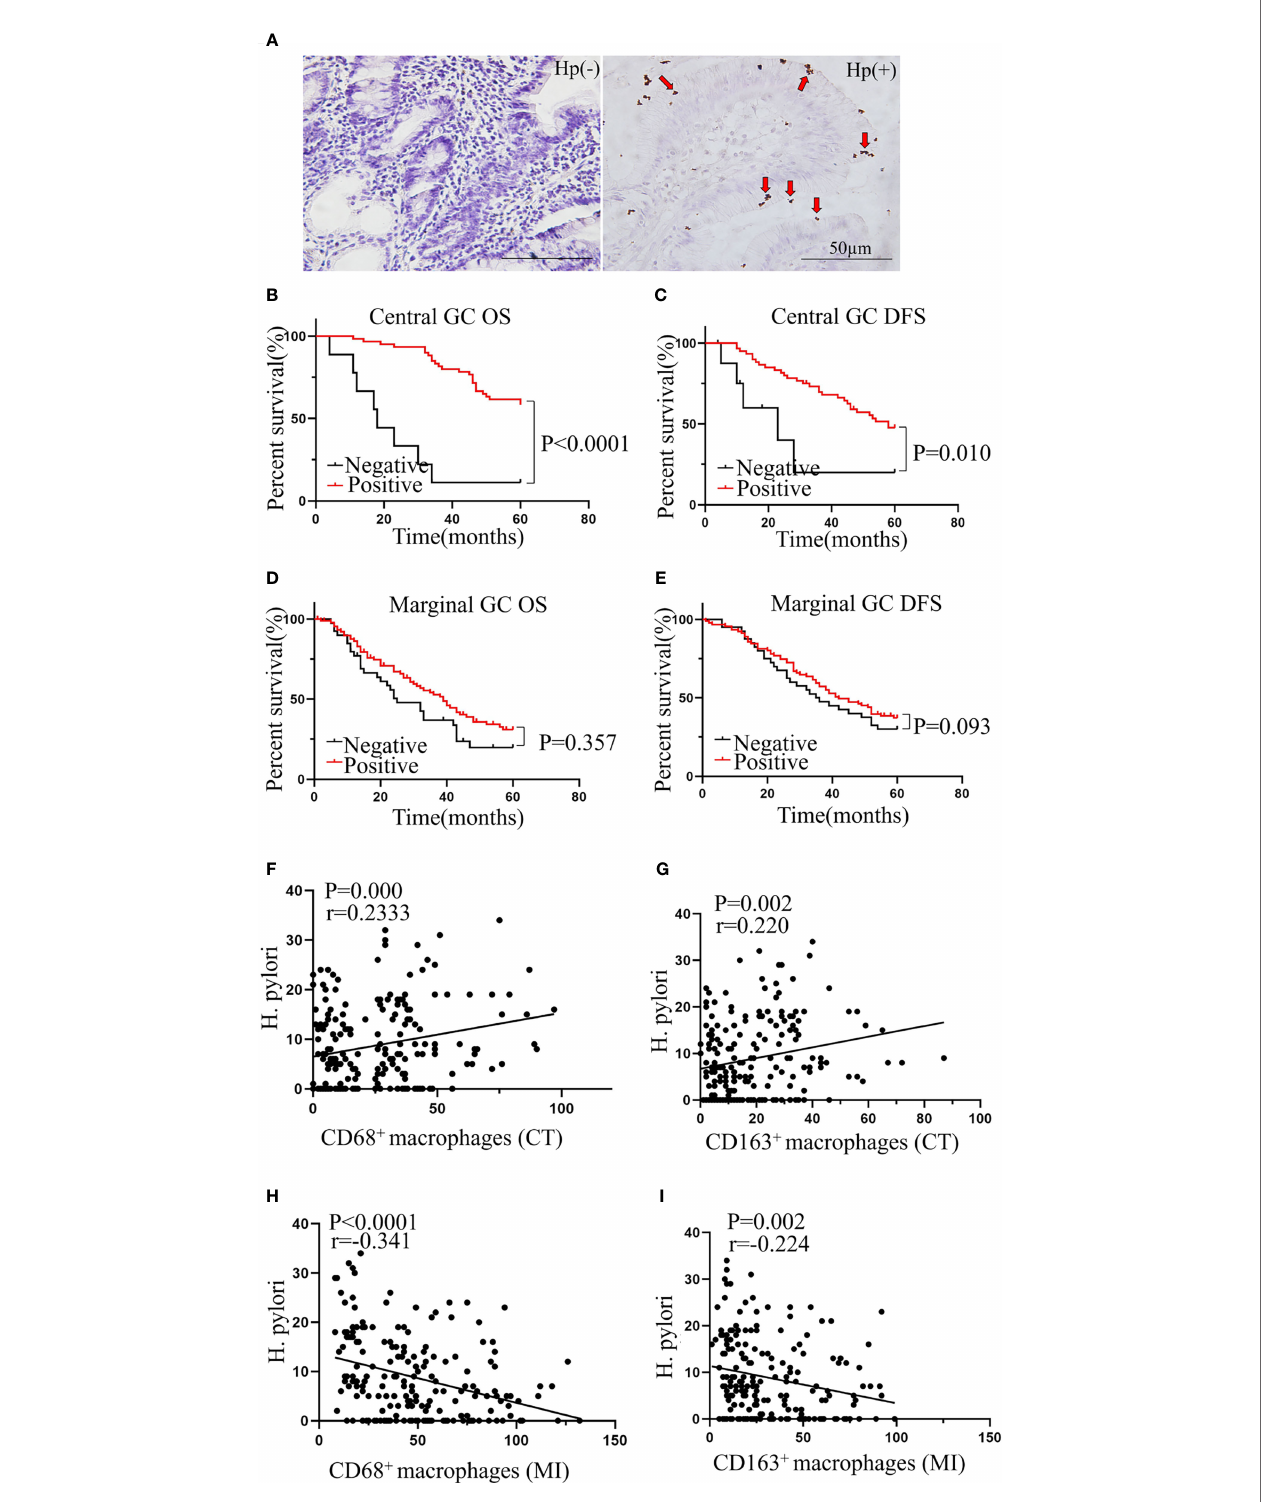
FIGURE 5 | Positive H. pylori status in central GC was signi fi cantly associated with better prognosis and TAM in fi ltration. (A) Representative picture of immunohistochemical staining of Helicobacter pylori . (B, C) Positive H. pylori status was signi fi cantly associated with better OS and DFS in central GC and was not associated with better OS and DFS in marginal GC (D, E) . (F – I) The correlation between the TAMs in different locations and H. pylori . CT, core of primary tumors; MI, invasive margin of primary